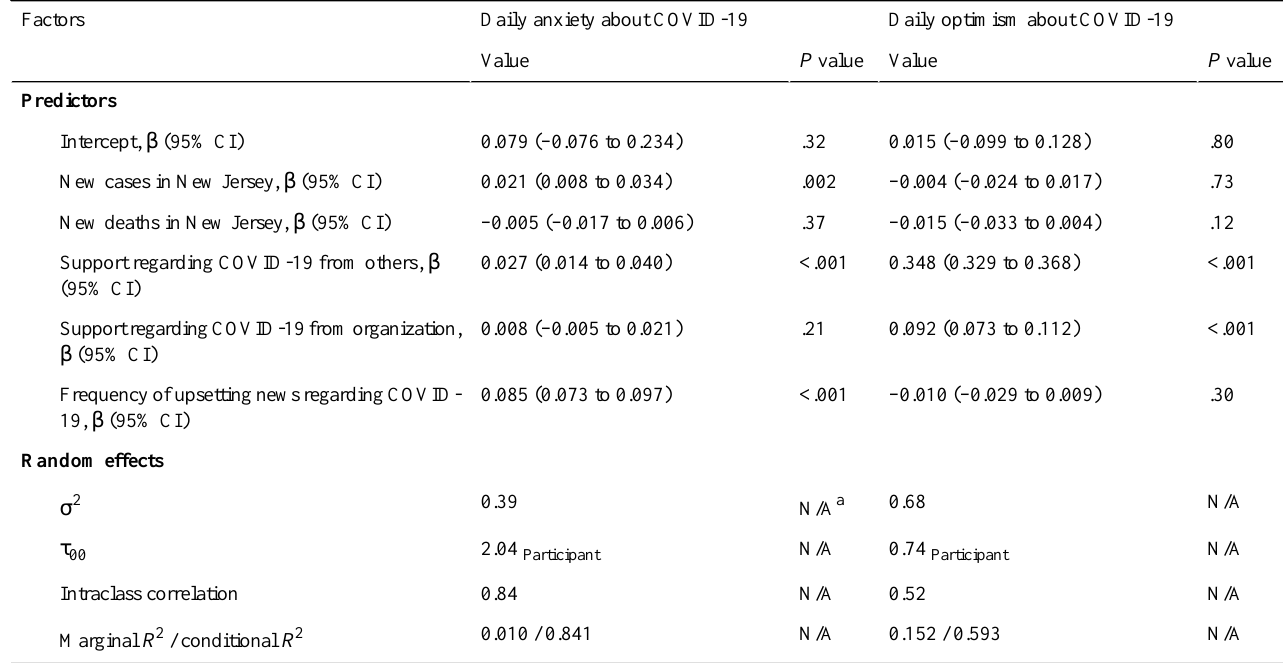
Table 1. Result of multilevel models showing which factors coincide with anxiety and optimism about COVID-19.